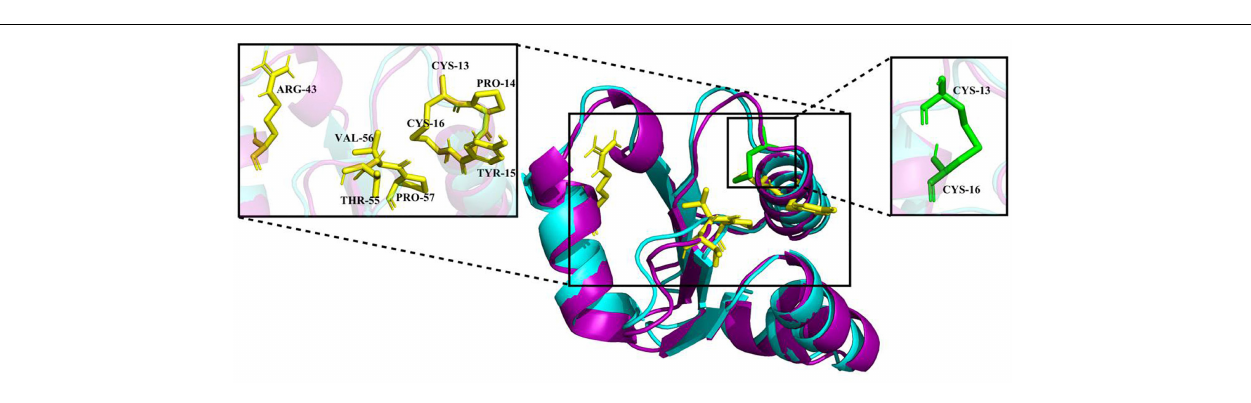
Frontiers in Microbiology |